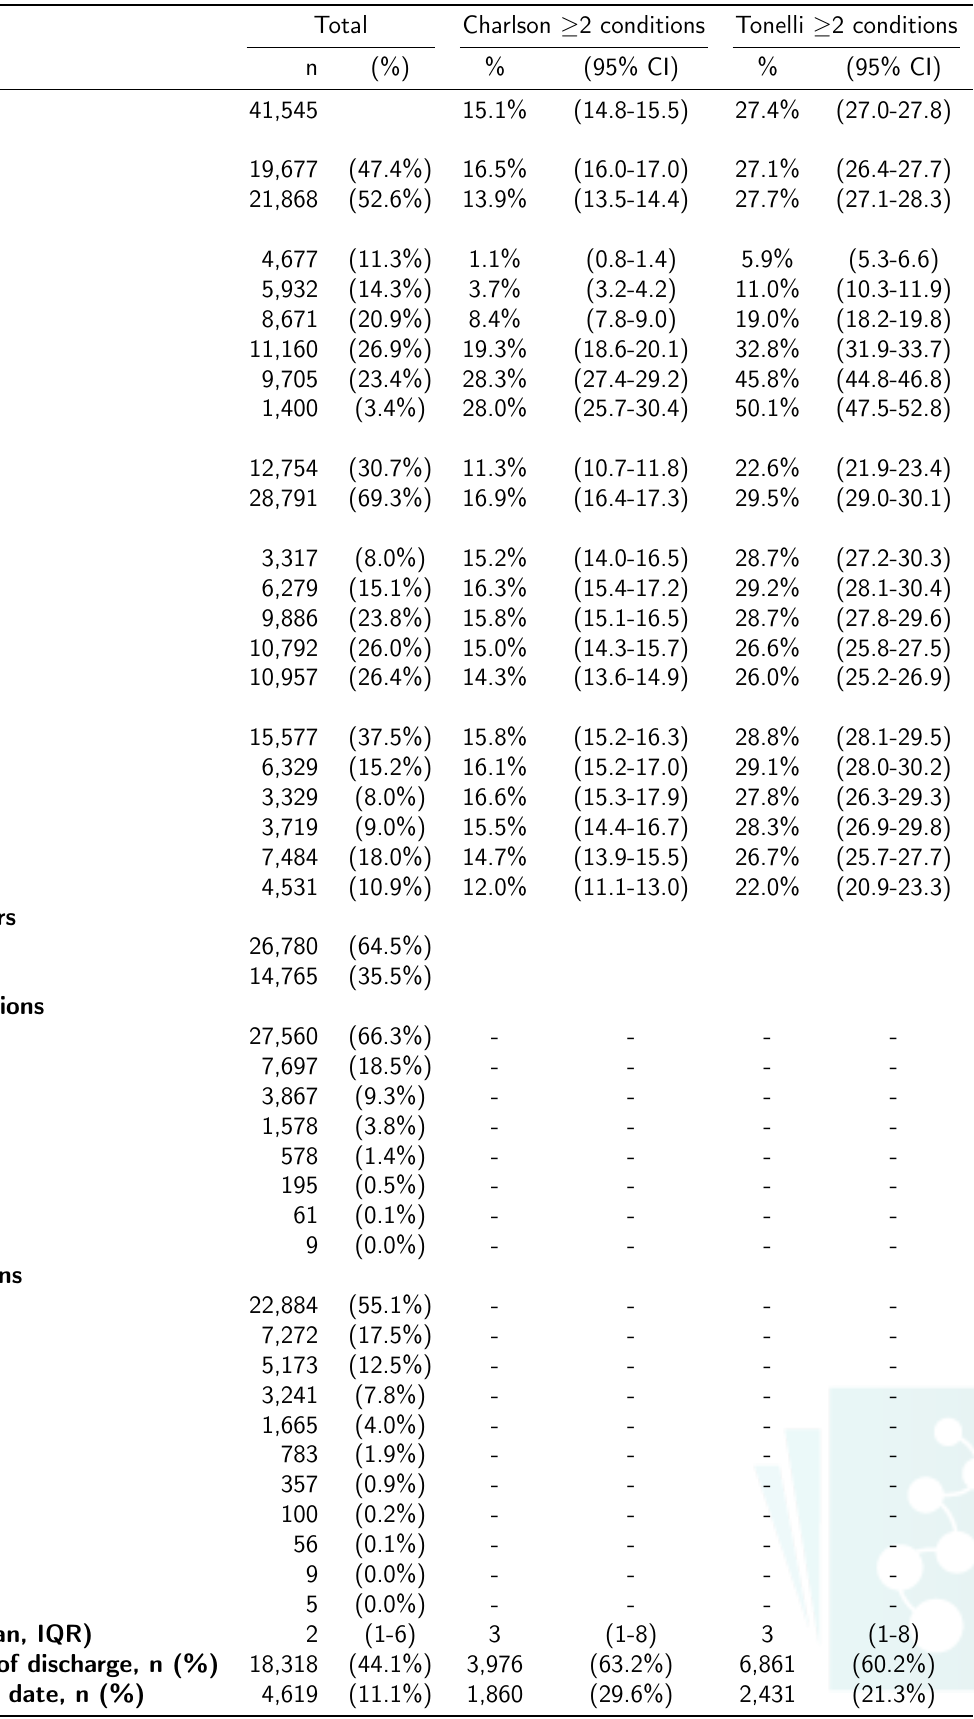
Table 1: Baseline characteristics and prevalence of multimorbidity by two